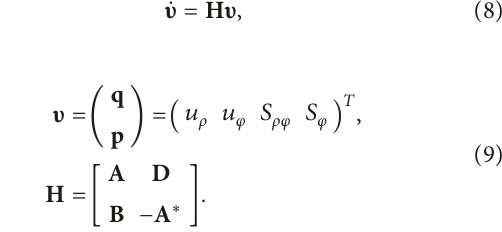
Figure 2: Polar coordinates sector